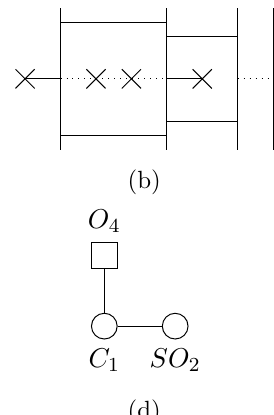
) of the maximal orbit (3 ; 1)